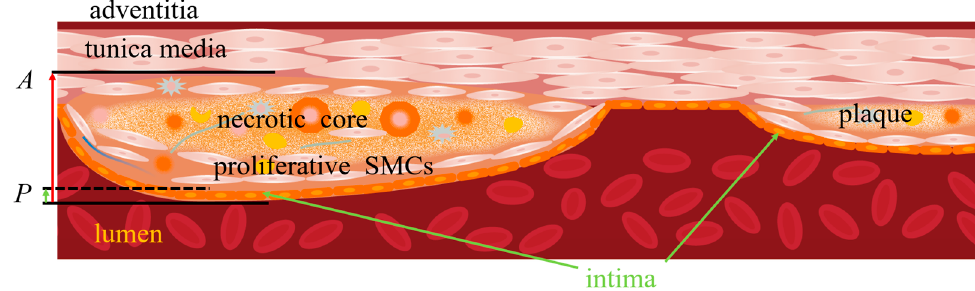
Figure 1. Illustration of two atherosclerotic lesions with different geometries. A and P define the ablation depth and the protection depth.